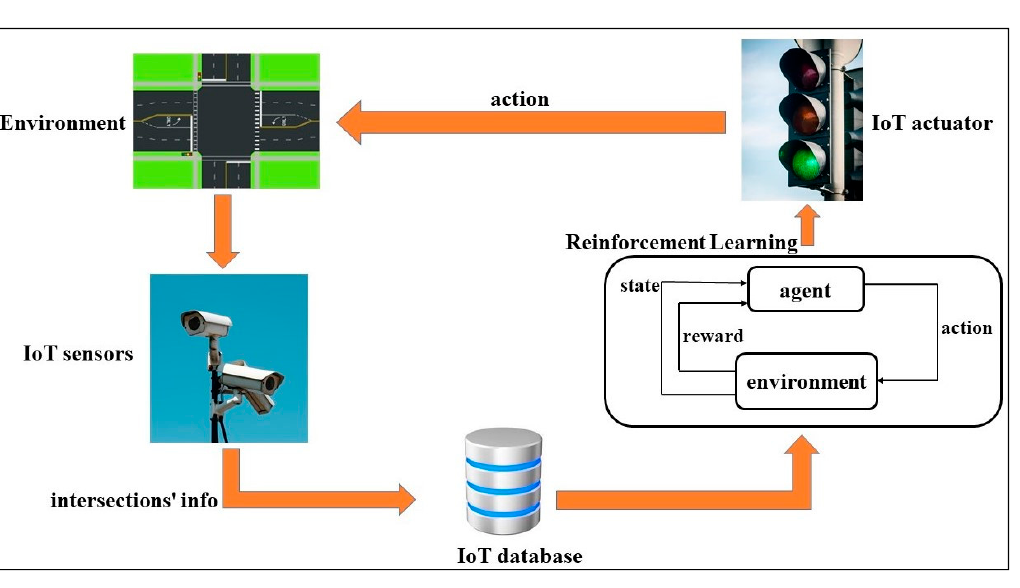
Figure 4. IoT and MARL approach for